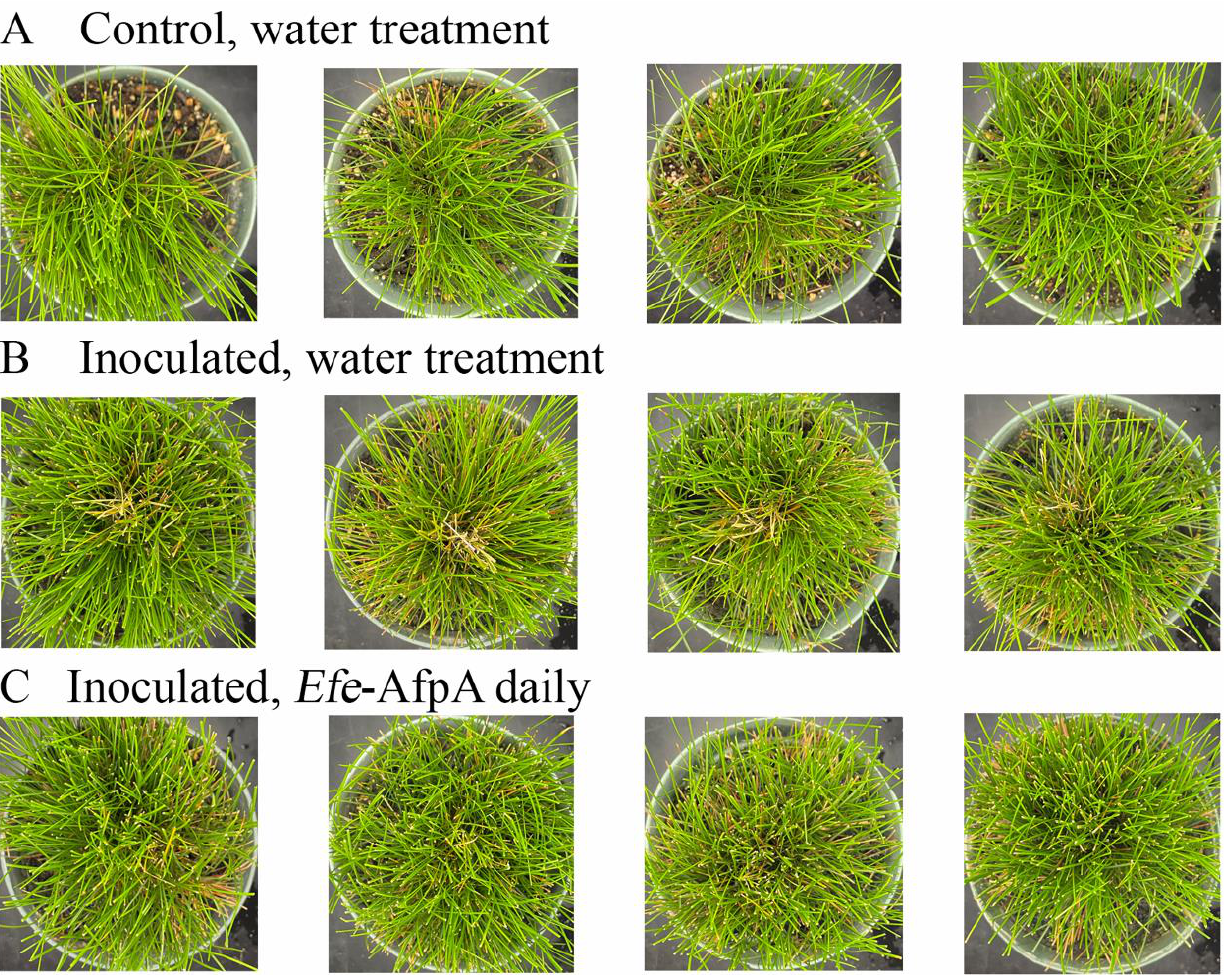
Figure 7. Efe -AfpA prevented severe symptoms of dollar spot disease when endophyte-free strong creeping red fescue plants were inoculated with an 8 mm plug of C. jacksonii . Plants were sprayed daily for 10 days with either water ( A , B ) or 100 µ g mL − 1 of Efe -AfpA ( C ). Photos within a row are replicates of the labeled treatment.